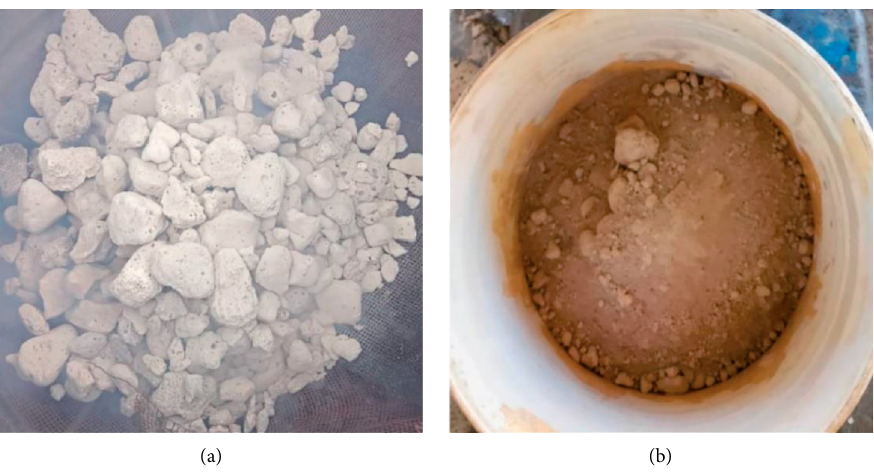
Figure 1: Coral aggregates: (a) natural form; (b) after crushing to fine sand size.